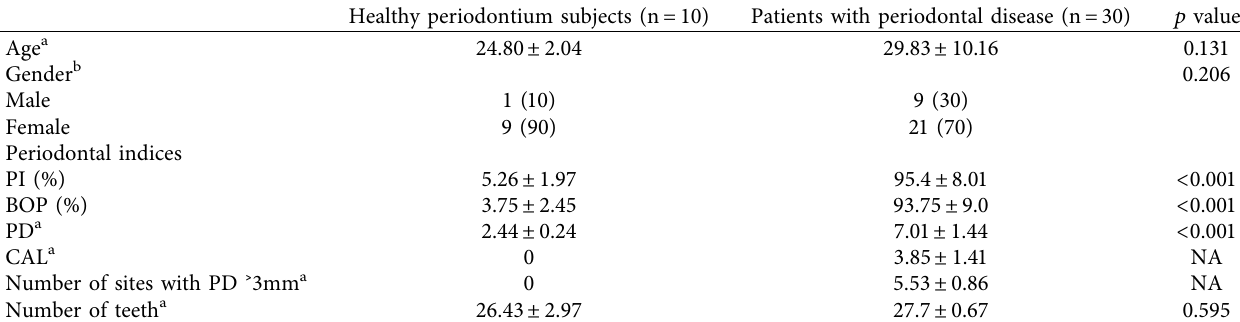
Table 1: Demographics and clinical characteristics of the